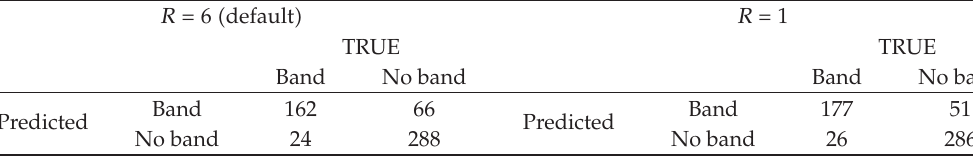
Table 4: Confusion matrix.